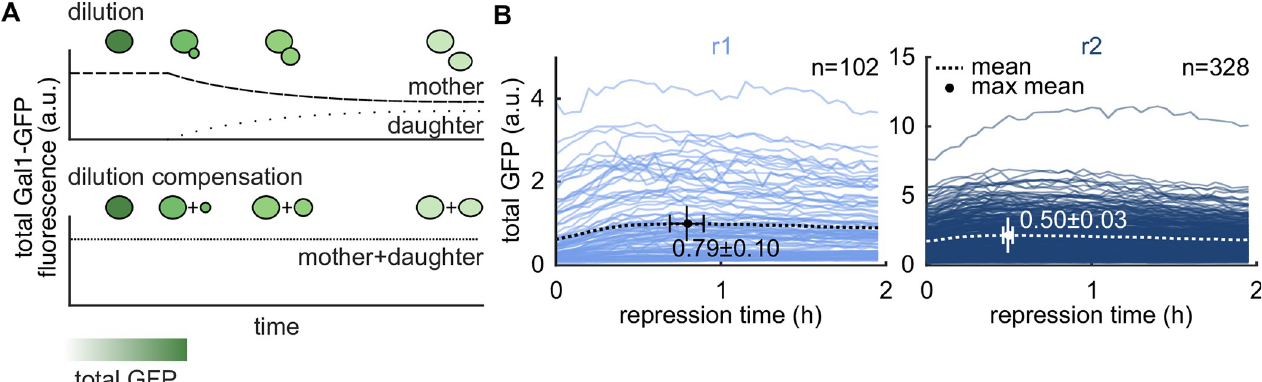
Fig 2. Dilution effects cannot explain the faster response upon repeated repression. (A) Budding decreases the total Gal1-GFP fluorescence signal in mother cells and increases the total Gal1-GFP fluorescence signal in daughter cells (top). To compensate for this dilution, we summed up the total Gal1-GFP fluorescence signal of each mother cell present and its progeny during one repression (bottom). (B) Single-cell traces of total GFP signal adjusted for dilution (see (A)) for the first two hours of repressions r1 (left) and r2 (right). Time to maximal mean total GFP is 17 min shorter in repression r2, where mean total GFP is indicated by the dotted line, the maximal mean total GFP is highlighted by the dot. Bootstrap (10 5 ) samples were drawn to generate mean ±